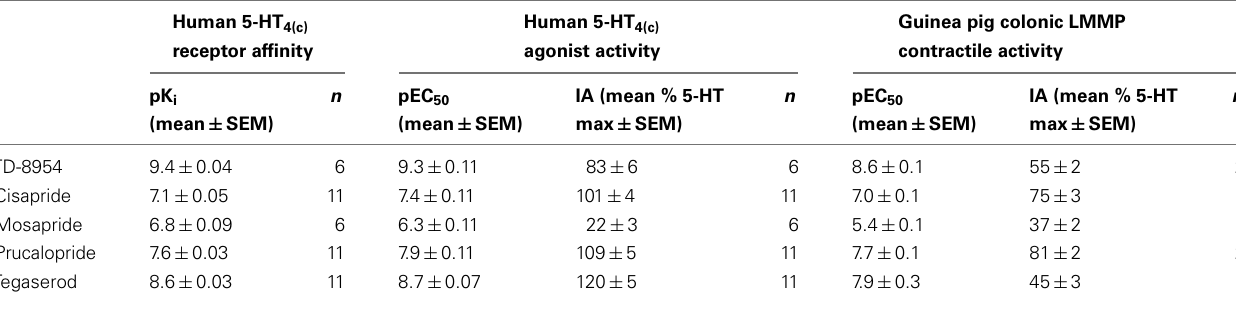
Table 1 | Human 5-HT 4(c) binding affinity (HEK293-h5-HT 4(c) ; pK i ), and human (HEK293-h5-HT 4(c) ) and guinea pig colonic longitudinal muscle/myenteric plexus (LMMP) agonist potency (pEC 50 ) and intrinsic activity (IA; % 5-HT maximum) values forTD-8954, cisapride, mosapride, prucalopride, and